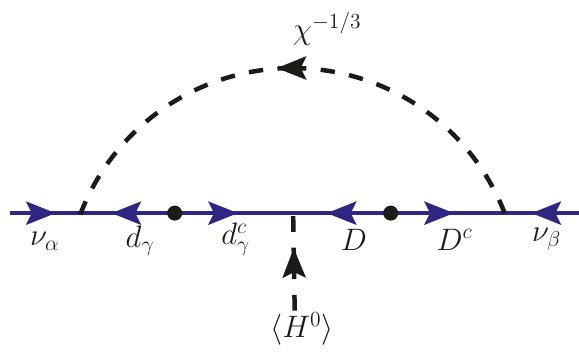
Figure 39 . Neutrino mass generation in the one-loop singlet LQ model with vectorlike quarks. 4 This is the model of table 3 3 O